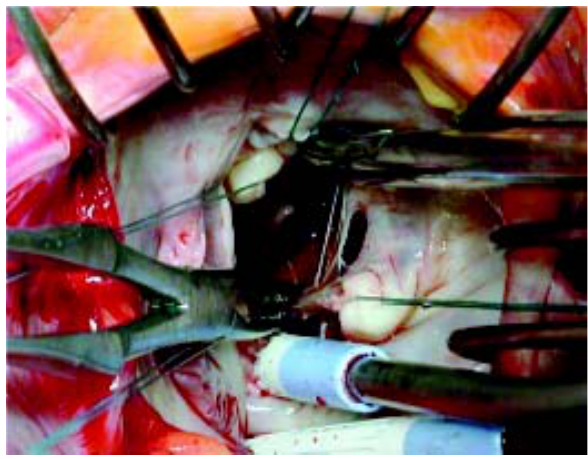
Fig. 2 - Técnica cirúrgica de reposicionamento do músculo papilar. Identificando e dividindo as cabeças do músculo papilar